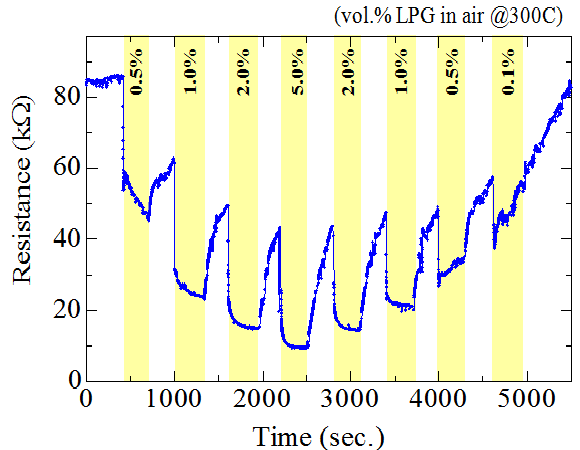
Figure 10. Dynamic resistance response at 300 °C of the 3.5 wt.% F-doped SnO an alternating environment of air and LPG (0.1~5.0